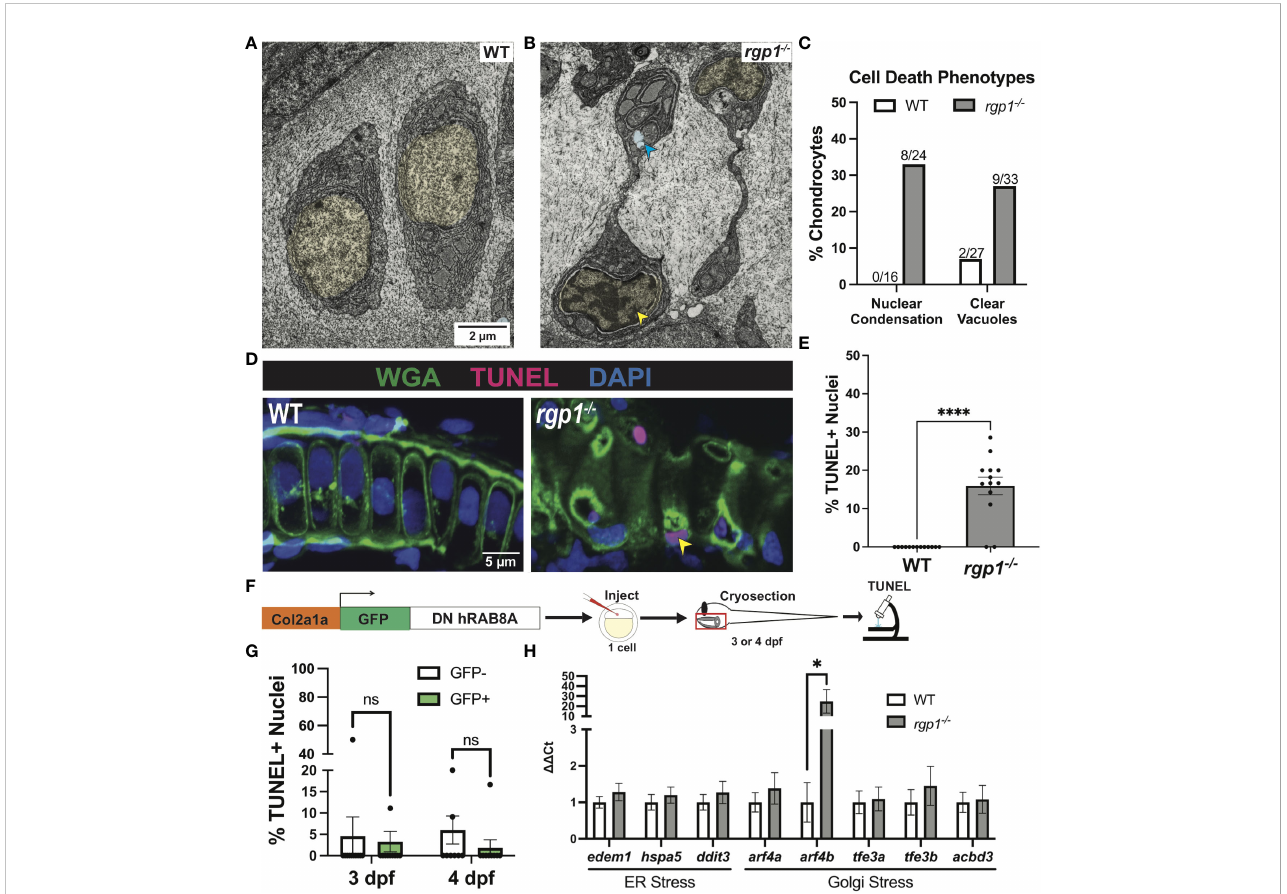
FIGURE 6 rgp1 -/- chondrocytes undergo cell death and induce a Golgi stress marker. (A) TEM images of 3 dpf WT chondrocytes showing normal cellular morphology. (B) rgp1 -/- craniofacial chondrocytes showing partial nuclear condensation (yellow shading, blue arrow) and clear cytoplasmic vacuoles (blue shading, blue arrow). (C) Quanti fi cation of cell death-associated TEM phenotypes. (D) Representative images of chondrocytes labeled with TUNEL and WGA in WT and rgp1 -/- cartilage (TUNEL, magenta; WGA, green). Yellow arrowhead identi fi es TUNEL + nucleus. (E) Quanti fi cation of the percentage of nuclei that were TUNEL + in each image. (F) Experimental design for mosaic overexpression of DN GFP-hRAB8A fusion protein in zebra fi sh chondrocytes, as used in Figure 5A. (G) Quanti fi cation of the percentage of nuclei that were TUNEL + in each image at 3 dpf or 4 dpf (H) qPCR panel of ER stress transcripts ( edem1 , bip , chop ) and Golgi stress transcripts ( arf4a, arf4b, tfe3a, tfe3b, acbd3 ) normalized to ef-1 transcript levels in 3 dpf larvae. Signi fi cance is presented by *p<0.05; ****p<0.0001; ns, not sign fi